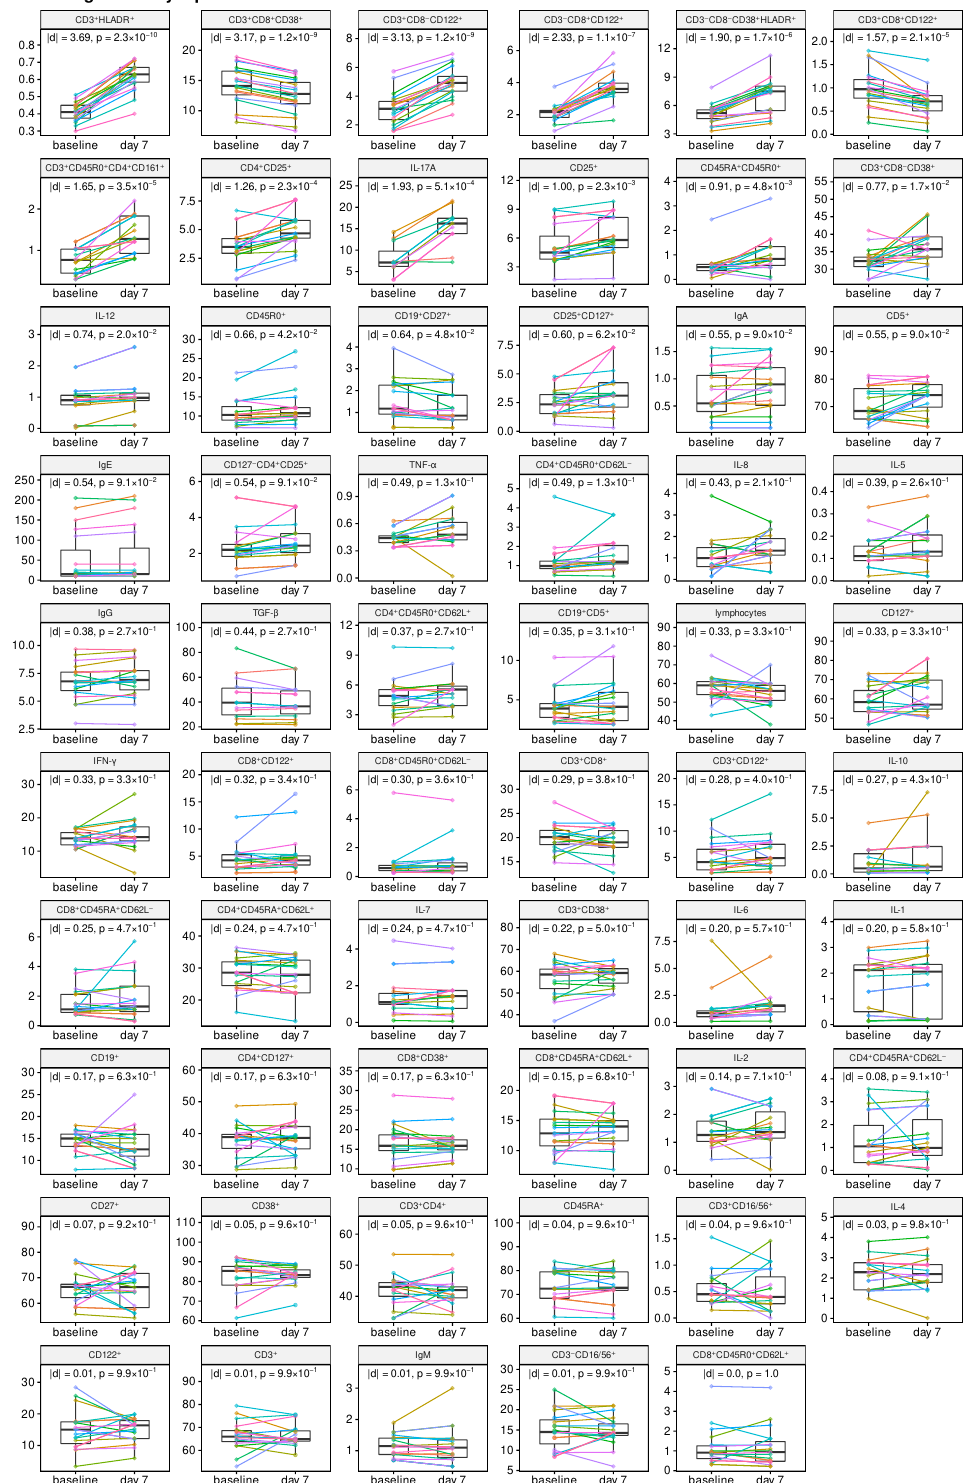
Figure 5. Analysis of the variable changes from baseline (day 0) to day 7 post-vaccination using the paired t -test. The effect size measured as the absolute value of the Cohen’s d-value and p -value adjusted to control over false discovery rate are indicated. The variables are sorted by the effect size. The first 9 variables were used as potential predictor candidates in strategy (b1), the last 8 variables—in strategy